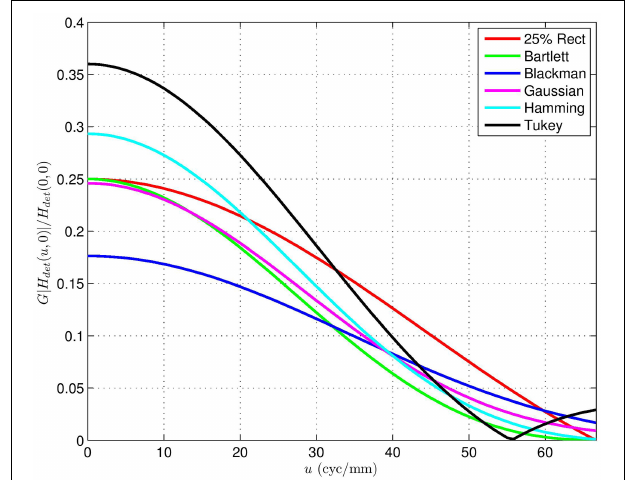
FIGURE 18 | Detector magnitude frequency response of the separable active areas in Figure 17 scaled relative to the DC gain of a 100% fill factor detector.